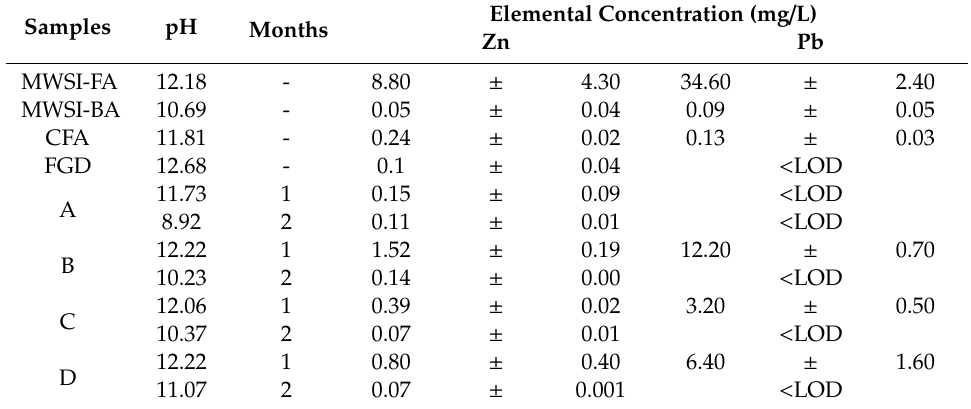
Table 2. Concentration of Zn and Pb in leaching solution of ashes and stabilized samples after one and two months. Results are reported as the average ± standard deviation of three TXRF measurements. Data about MSWI FA, BA, CFA, and FGD residues do not change in the two